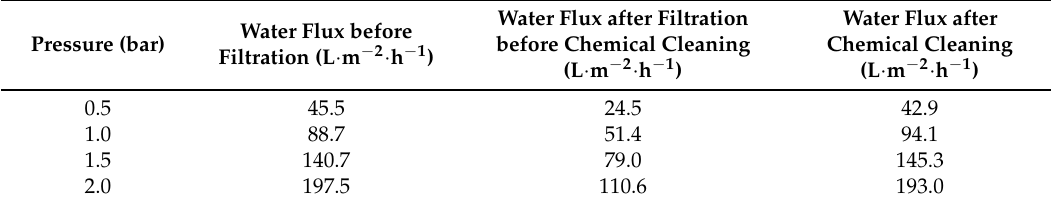
Table 5. Water fluxes at different TMPs before the filtration of spent sulfite liquor, after filtration, and after chemical